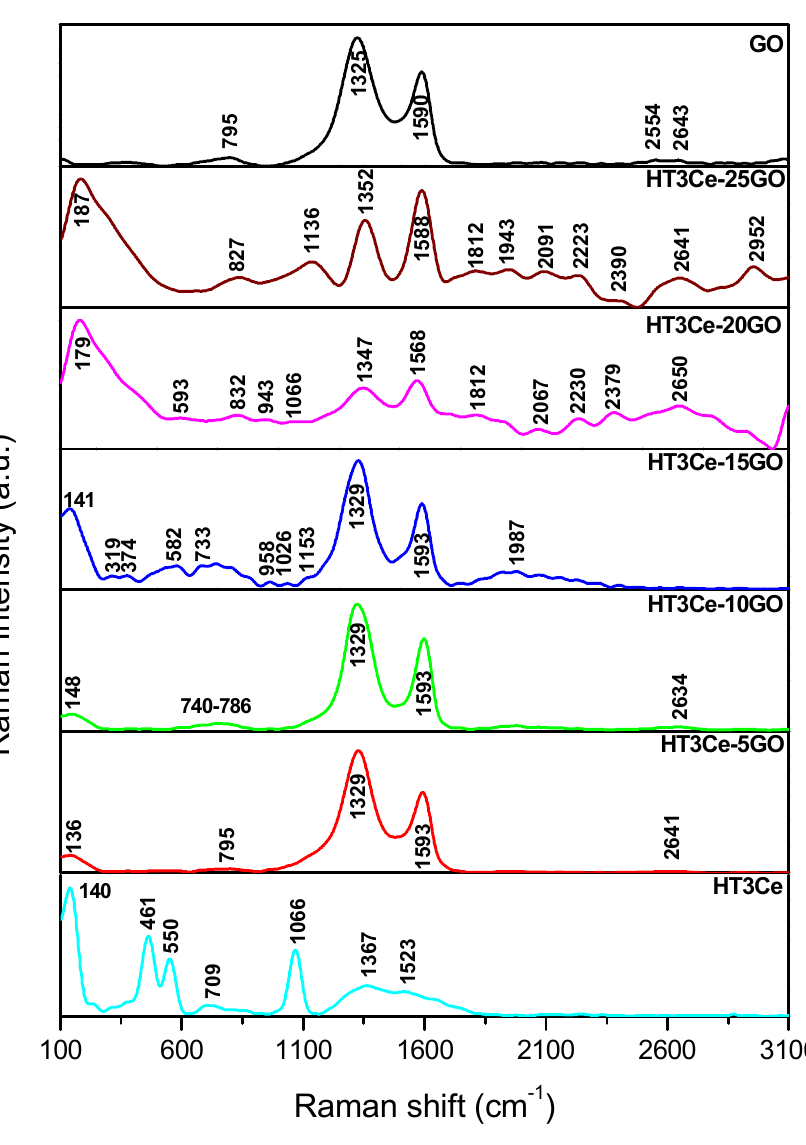
Figure 4. Raman spectra of the solids: HT3Ce-xGO composites, neat HT3Ce, and GO.